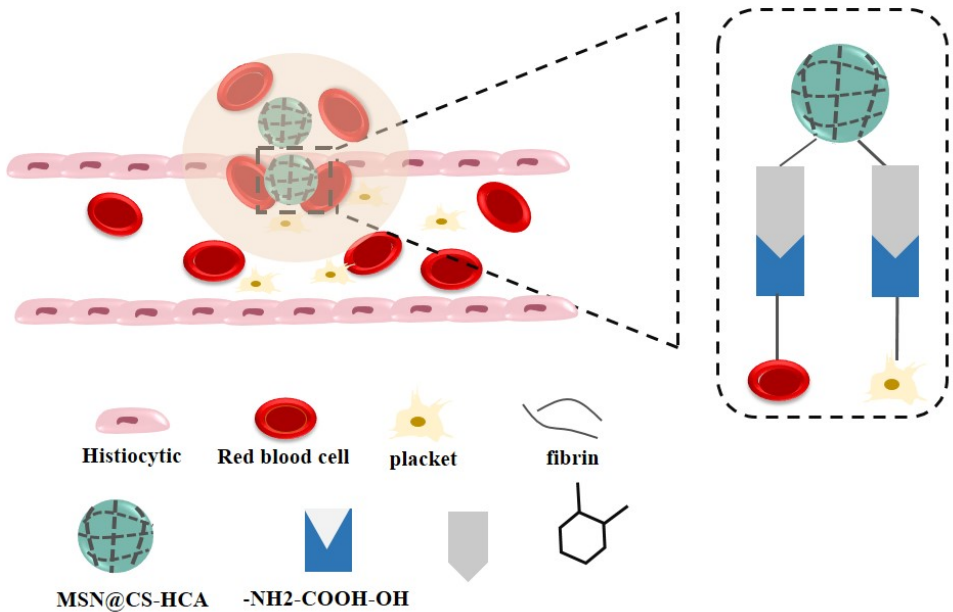
Figure 5. the hemostatic mechanism of MSN@CS-HCA. Figure 5. The hemostatic mechanism of